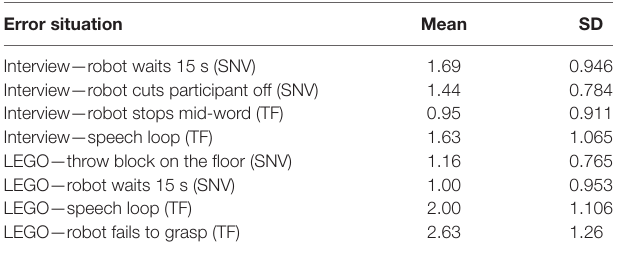
Table 6 | Mean number of social signals and standard deviation (sD) per error situation.